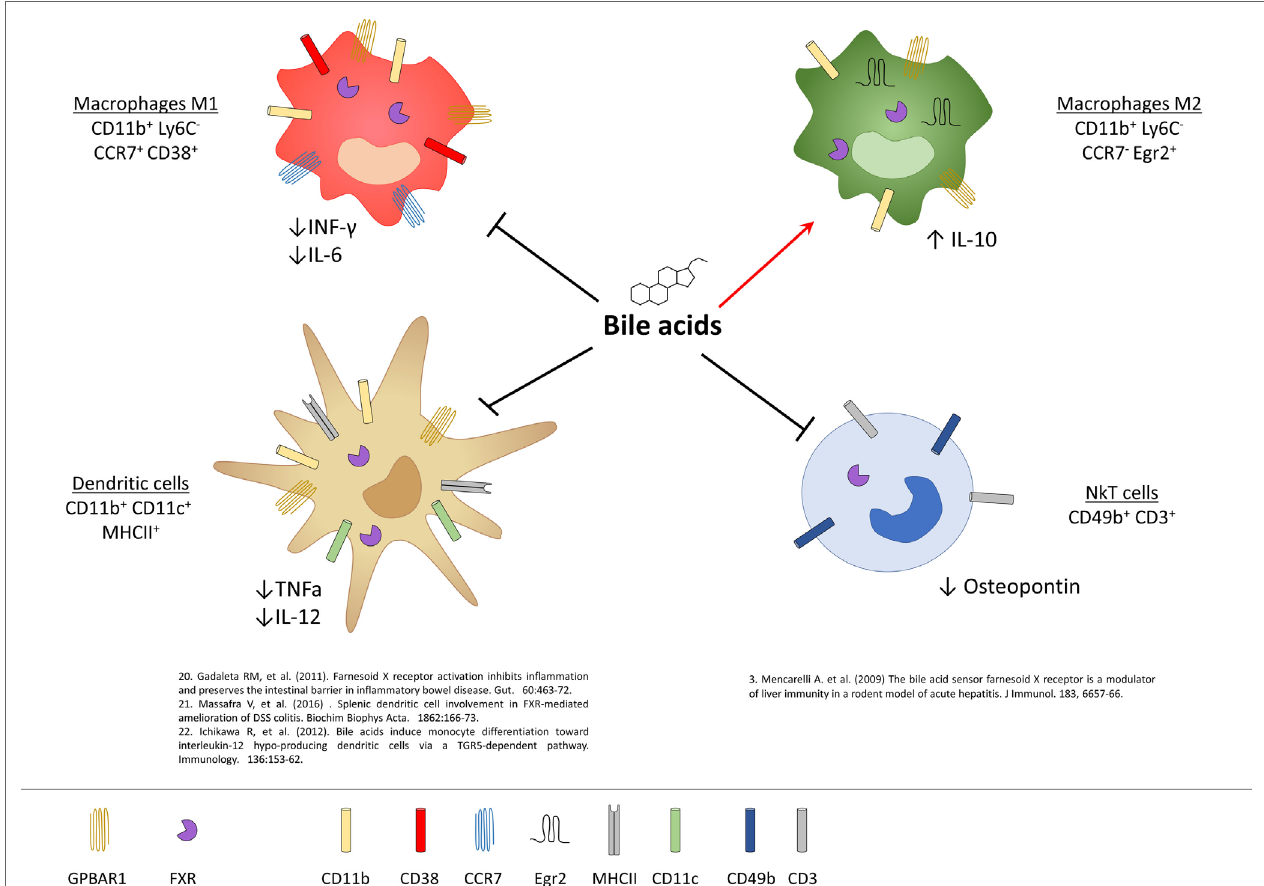
FiGuRe 3 | Expression of G-protein bile acid receptor 1 (GPBAR1) and Farnesoid-X-Receptor (FXR) in cells of innate immunity and their functional role. Macrophages and dendritic cells (DCs) express both GPBAR1 and FXR receptors, while for NKT cells there is currently only evidence of the expression of FXR. In macrophages, activation of these receptors by bile acids induces a polarization toward the anti-inflammatory M2 phenotype with an upregulation of IL-10 and a downregulation of the pro-inflammatory cytokines IL-6 and INF- γ . Bile acids, on the other hand, act on the DCs down-regulating the production of TNF- α and IL-12, while in NKT cells they decrease the expression of